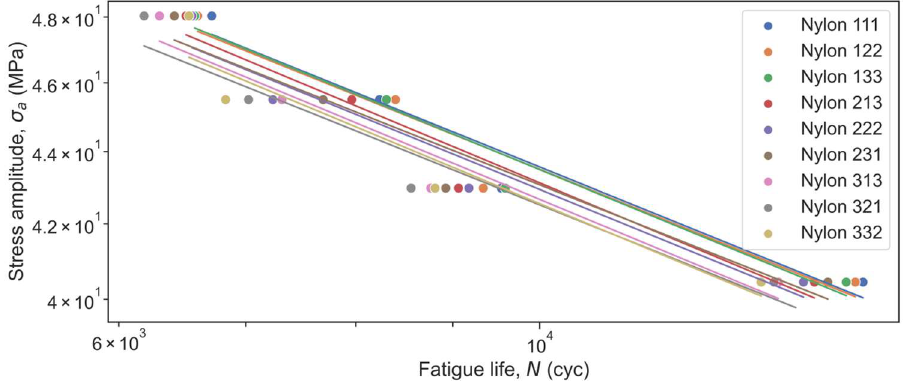
Figure 6. Experimental S-N curve for Nylon.